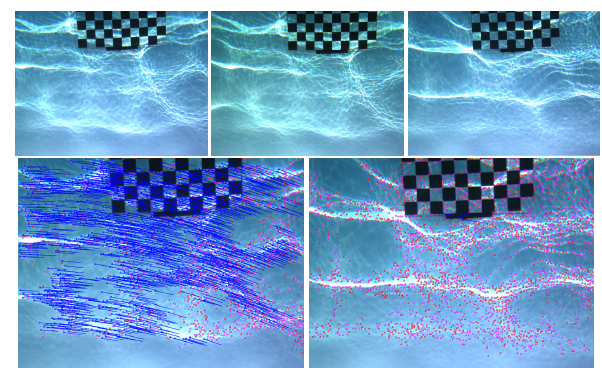
Figure 10. Example of matching result on a synchronised pair (left) and desynchronised pair (right) of caustics: we get 80% of inliers for the synchronized pair and less than 1% for the desynchronised pair.